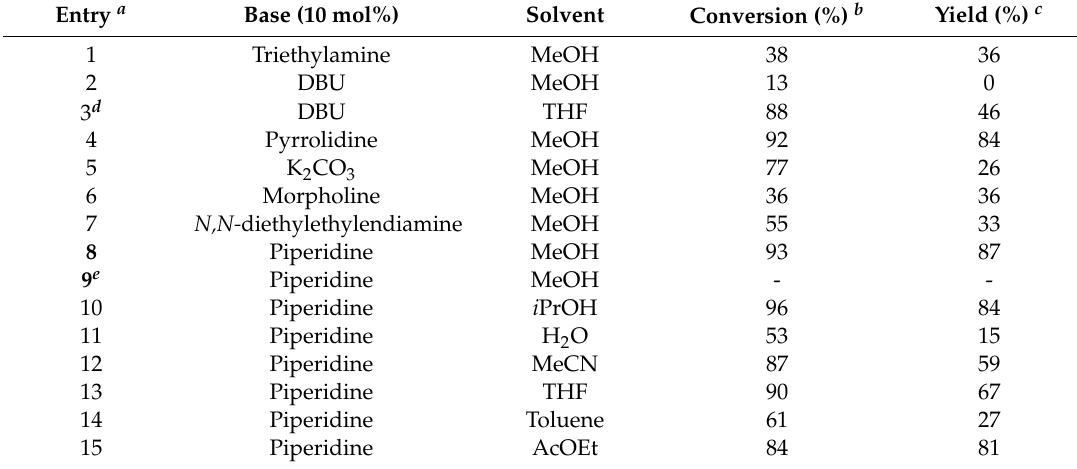
Table 1. Screening of di ff erent bases for the synthesis of